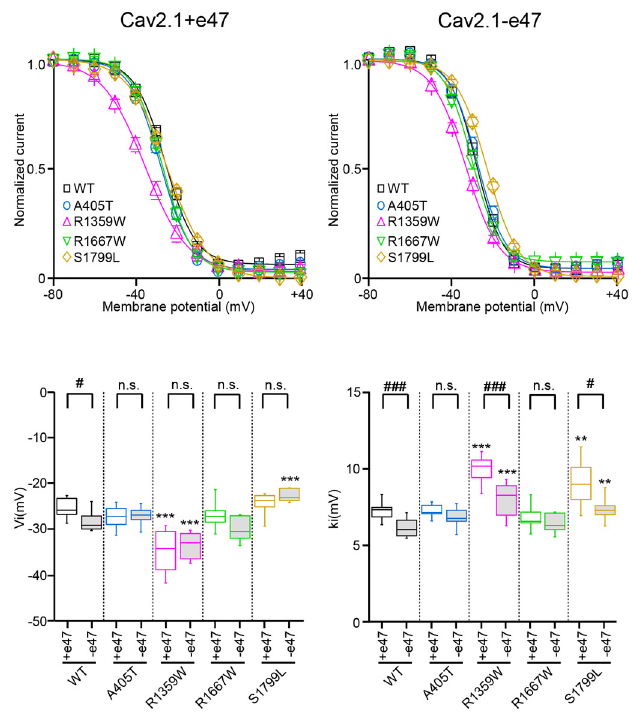
Figure 4. Voltage dependence of Cav2.1 inactivation. ( Top ) Voltage-dependent isochronal inactiva-